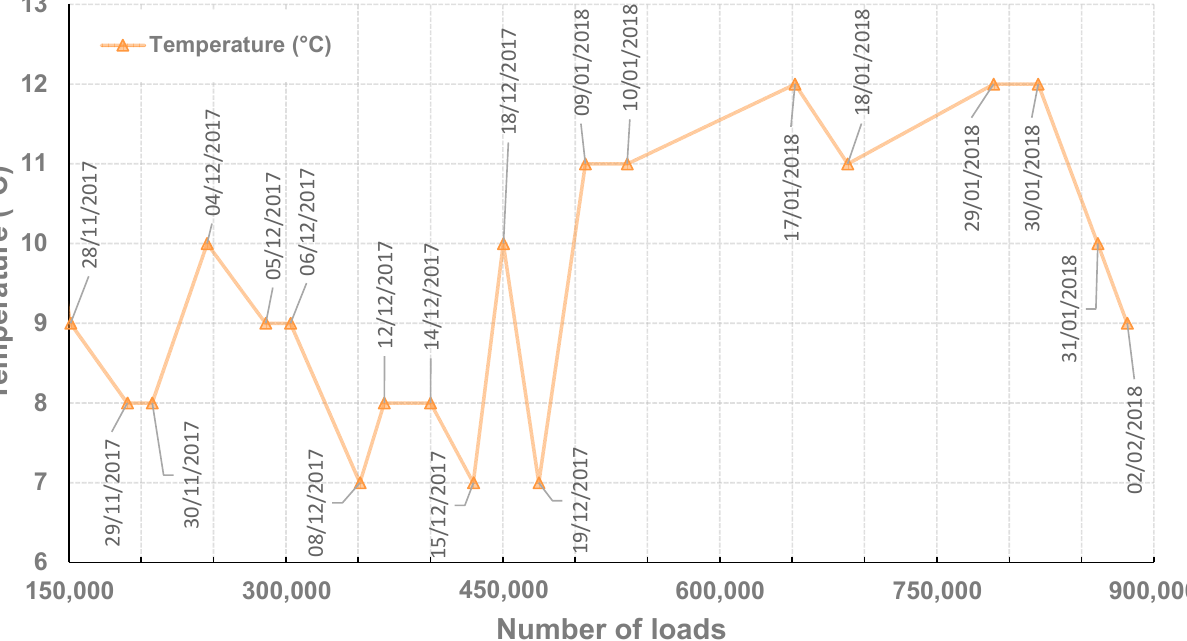
Figure 5. Mean temperatures and date of acquisition recorded inside the bituminous layer as a function of the number of loads.